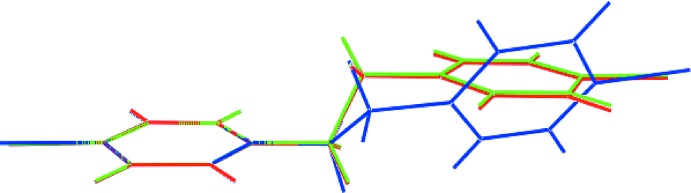
Overlap diagram of the (a) Cl1A-mol­ecule in (I) (red image), (b) Cl1B-mol­ecule in (I) (green) and (c) the mol­ecule in (II) (blue). Mol­ecules have been overlapped so that the C1-benzene rings are coincident.